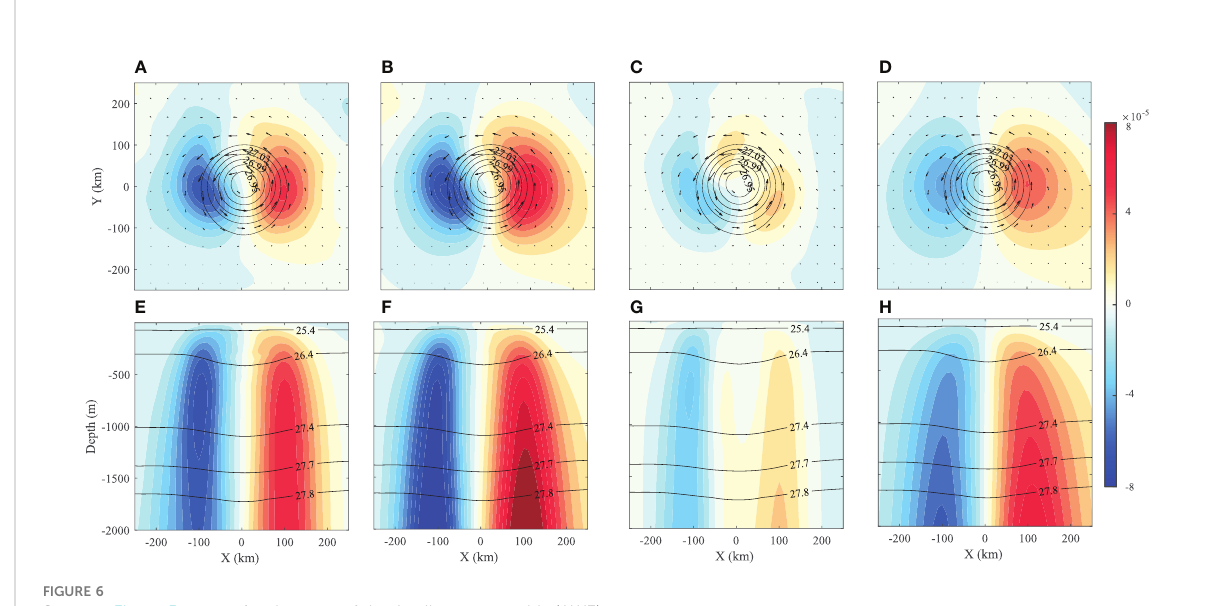
FIGURE 6 Same as Figure 5 except for the case of the Agulhas warm eddy